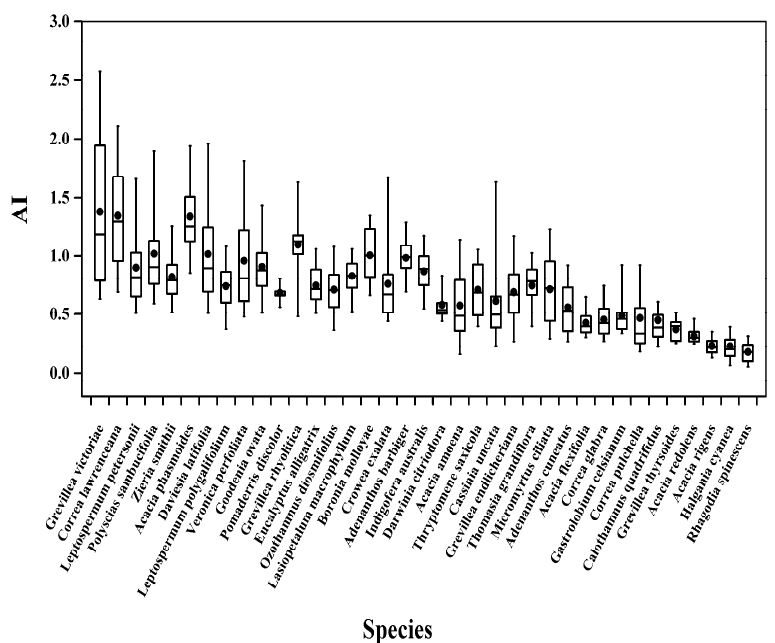
Figure 1. The climatic distributions of 37 shrubs species for all occurrence records in the Atlas of the Living Australia (2013) as represented by the mean annual aridity index (AI). The boxes mark the intervals between the 25th and 75th percentiles. The whiskers denote the intervals between the 5th and 95th percentiles. The solid circle represents the mean, and the line in the box represents the median.